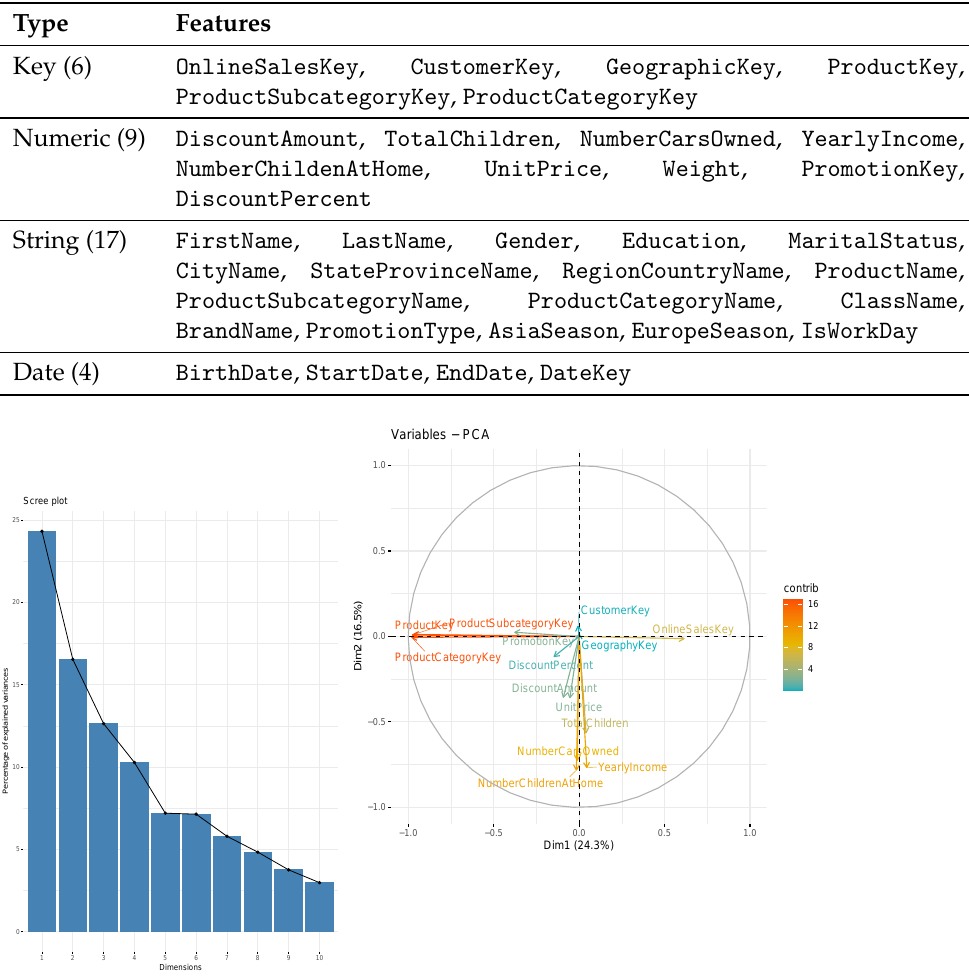
Figure 5. Principal component analysis of the dataset. The left panel shows the 10 first eigenvalues in decreasing order of the explained variance. The right panel depicts the correlations among features for the two highest principal